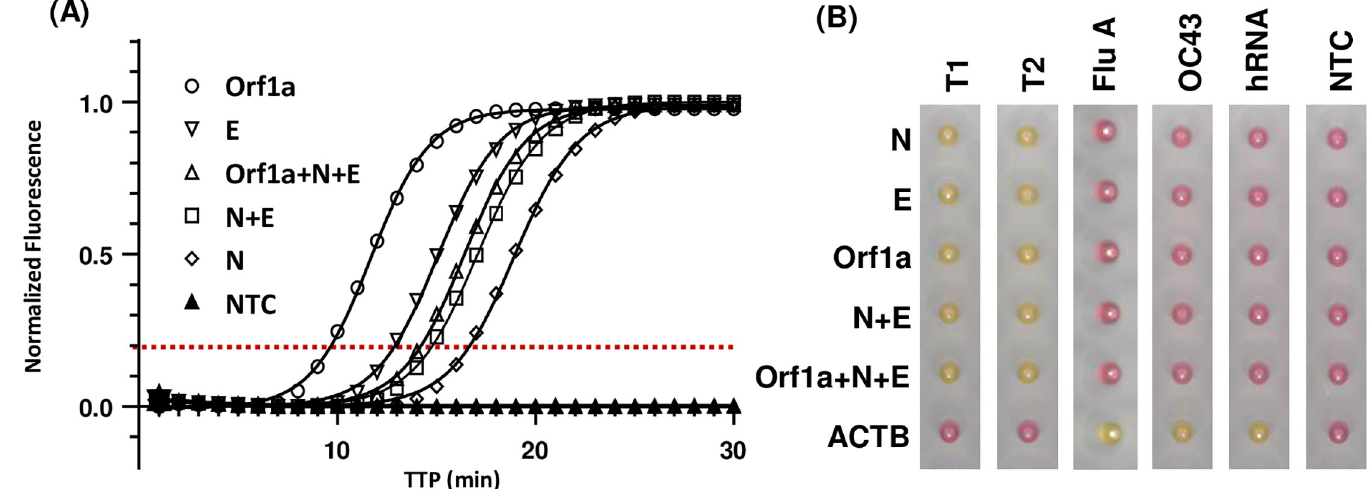
Fig 2. RT-LAMP primer investigation. SARS-CoV-2 RNA primer sets targeting the nucleopcapsid (N), envelope gene (E) (NEB design) and Orf1a (Rabe and Cepko Harvard Medical School) were tested independently and in combination (dual N+E reaction and multiplex Orf1a+N+E reaction) against 1x10 4 copies of Twist synthetic SARS-CoV-2 control RNA (T1 and T2). Negative control RNA from Betacoronavirus 1 strain OC43 and Influenza A (H1N1) at a single concentration (1x10 5 copies per well) plus a water no template control (NTC). A total RNA control primer set (NEB) targeting human beta actin (ACTB) was also included and tested against 5 ng total human RNA (hRNA). Both RT-LAMP fluorescent end-point and colorimetric 25 μ l reactions were performed at 65˚C for 40 minutes on a StepOnePlus thermoclycler. (A) Representative fluorescent amplification curves where time to positive (TTP) is the time at which amplification exceeds the manually set, reaction consistent threshold (red dotted line). (B) Representative colorimetric reactions whereby yellow indicates positive amplification and pink no